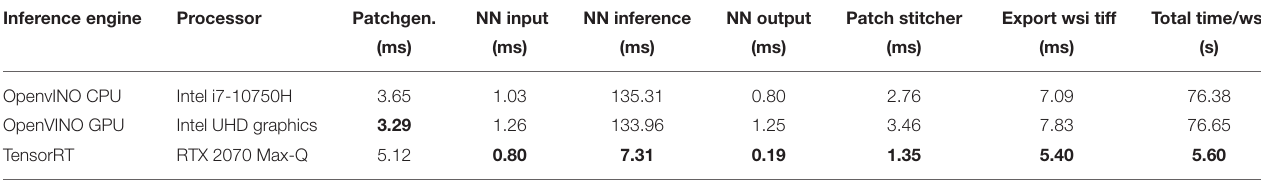
TABLE 2 | Runtime measurements of different inference engines using FastPathology. Inference